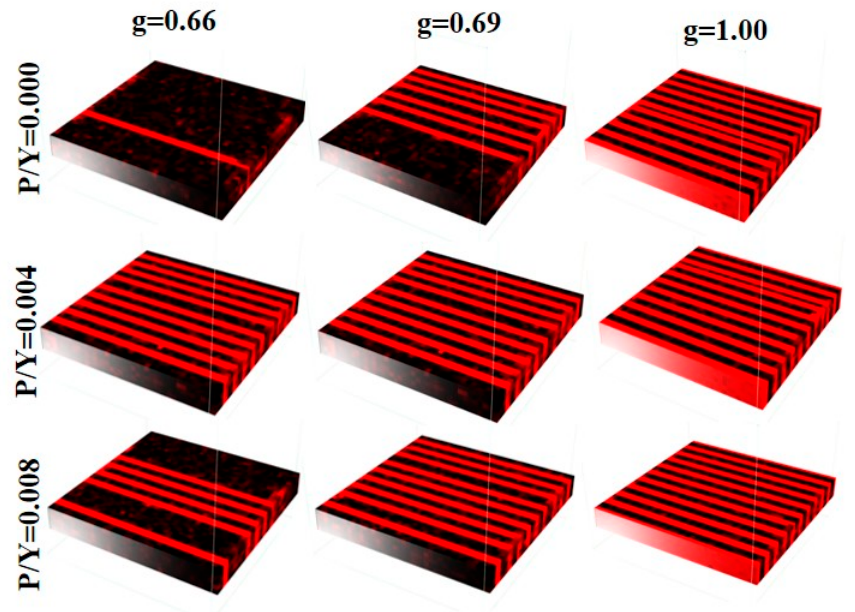
Figure 5. Magnetic configurations. Red indicates magnetic alignments of stripes in the − x direction and black indicates alignments in the + x direction.